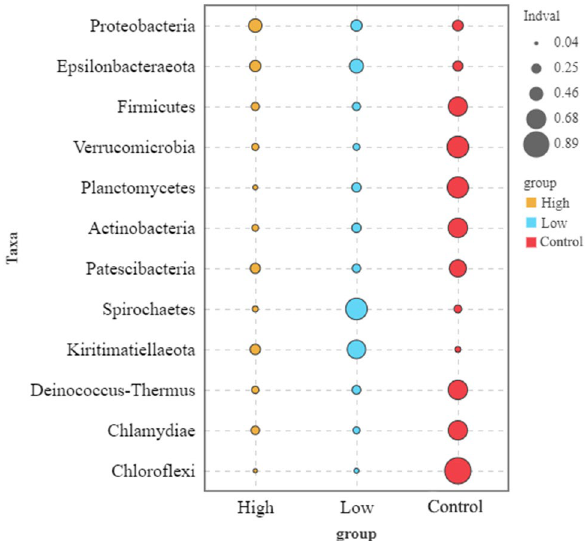
Figure 4. Indicator species ( P < 0.05) at the phylum level on S. thunbergii under increased UV-B radiation. Indicator analysis calculates the indicator value (IndVal) for each species in each group based on the abundance and frequency of occurrence of the species in the sample, with higher values indicating a greater likelihood of the species being an indicator species for that group.